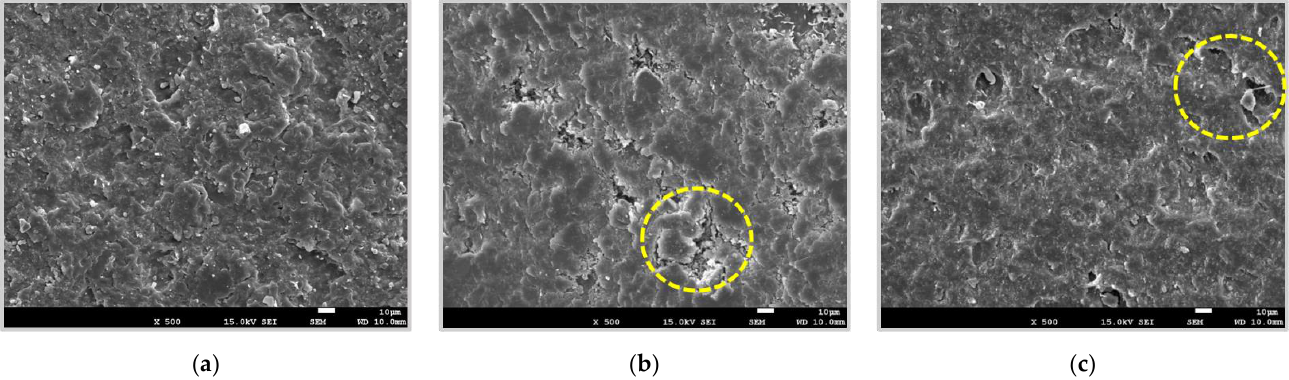
Figure 10. A void and a crack in the SEM image for the insulation of ( a ) non-aged cable; ( b ) 30 year accelerated aged cable; ( c ) 40 year accelerated aged cable.